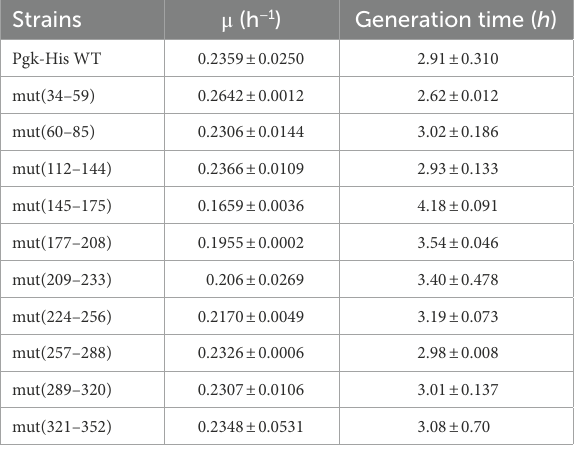
TABLE 3 Specific growth rate and generation time of WT and mutant